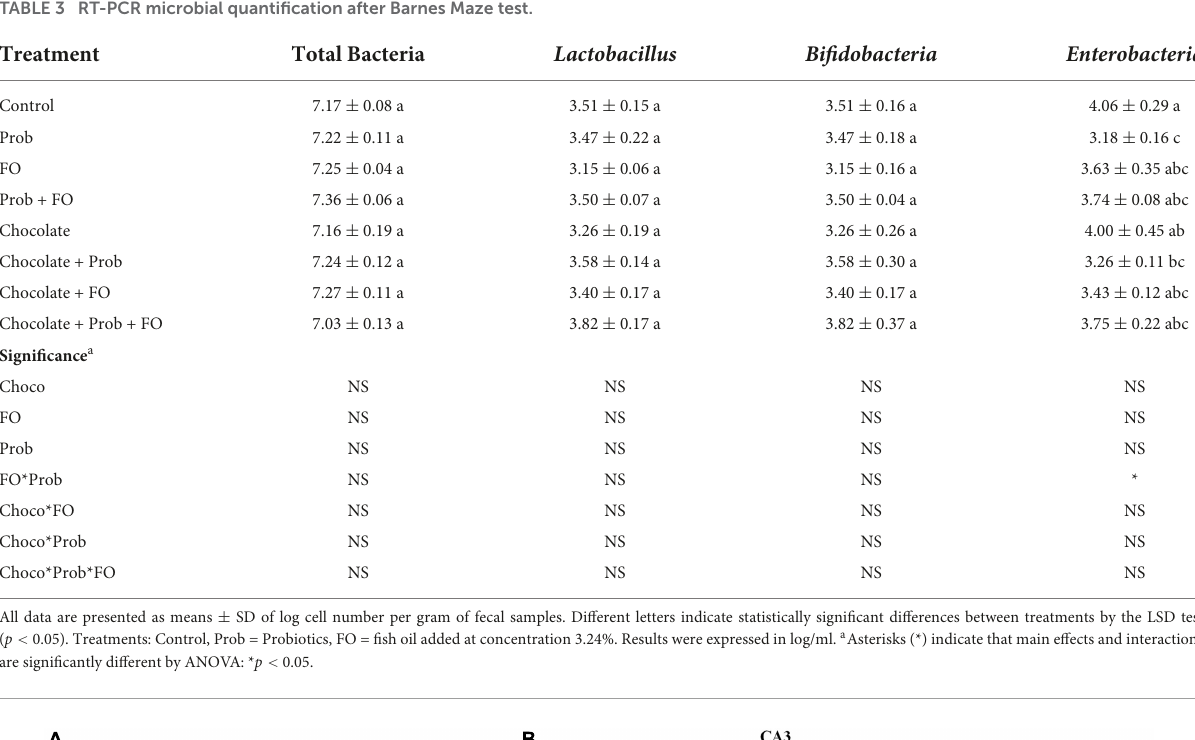
TABLE 3 RT-PCR microbial quantification after Barnes Maze test.